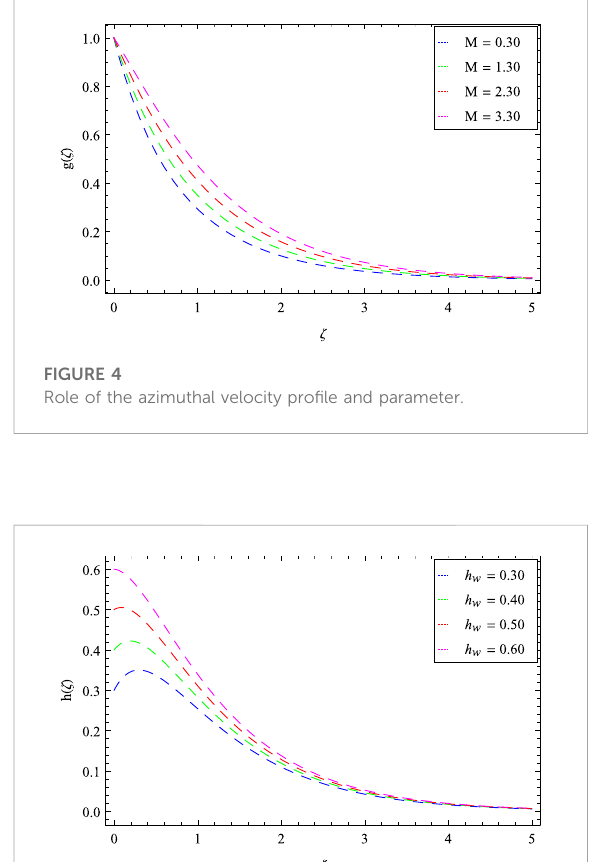
FIGURE 7 Role of the heat transfer pro fi le and